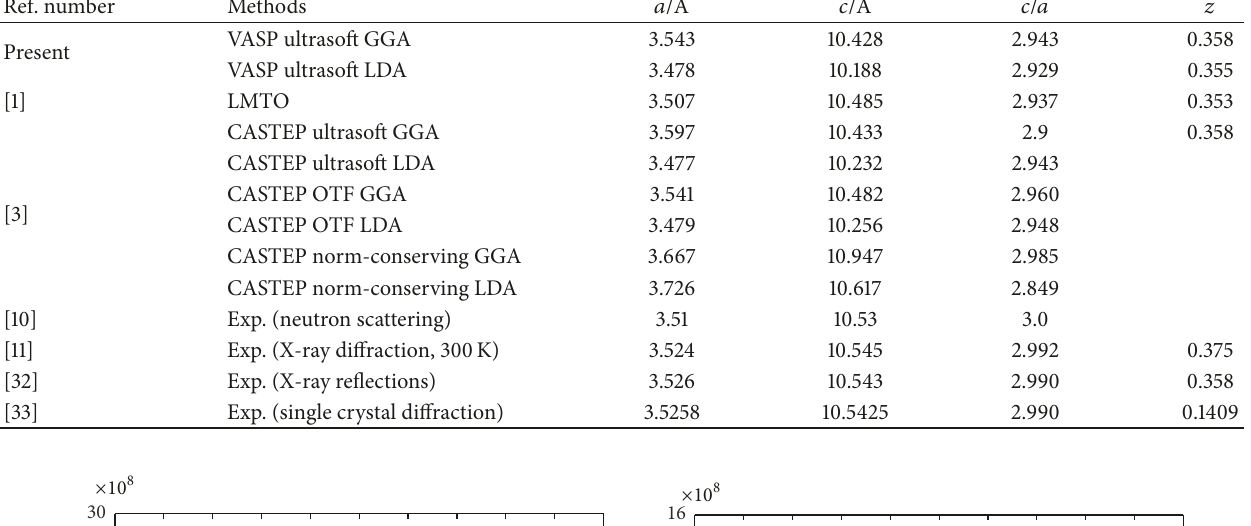
Table 2: Calculated lattice parameters at 𝑇 = 0K and 𝑃 = 0 GPa compared with the experimental data and other theoretical results. Ref. number